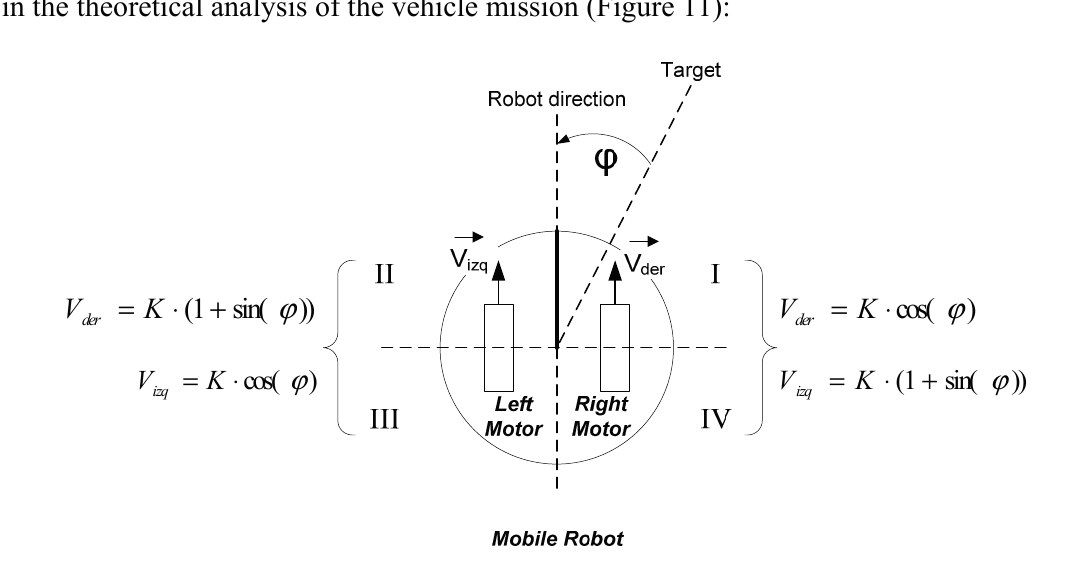
Figure 11. Path error ( φ ) in a mobile robot used to calculate the QoC